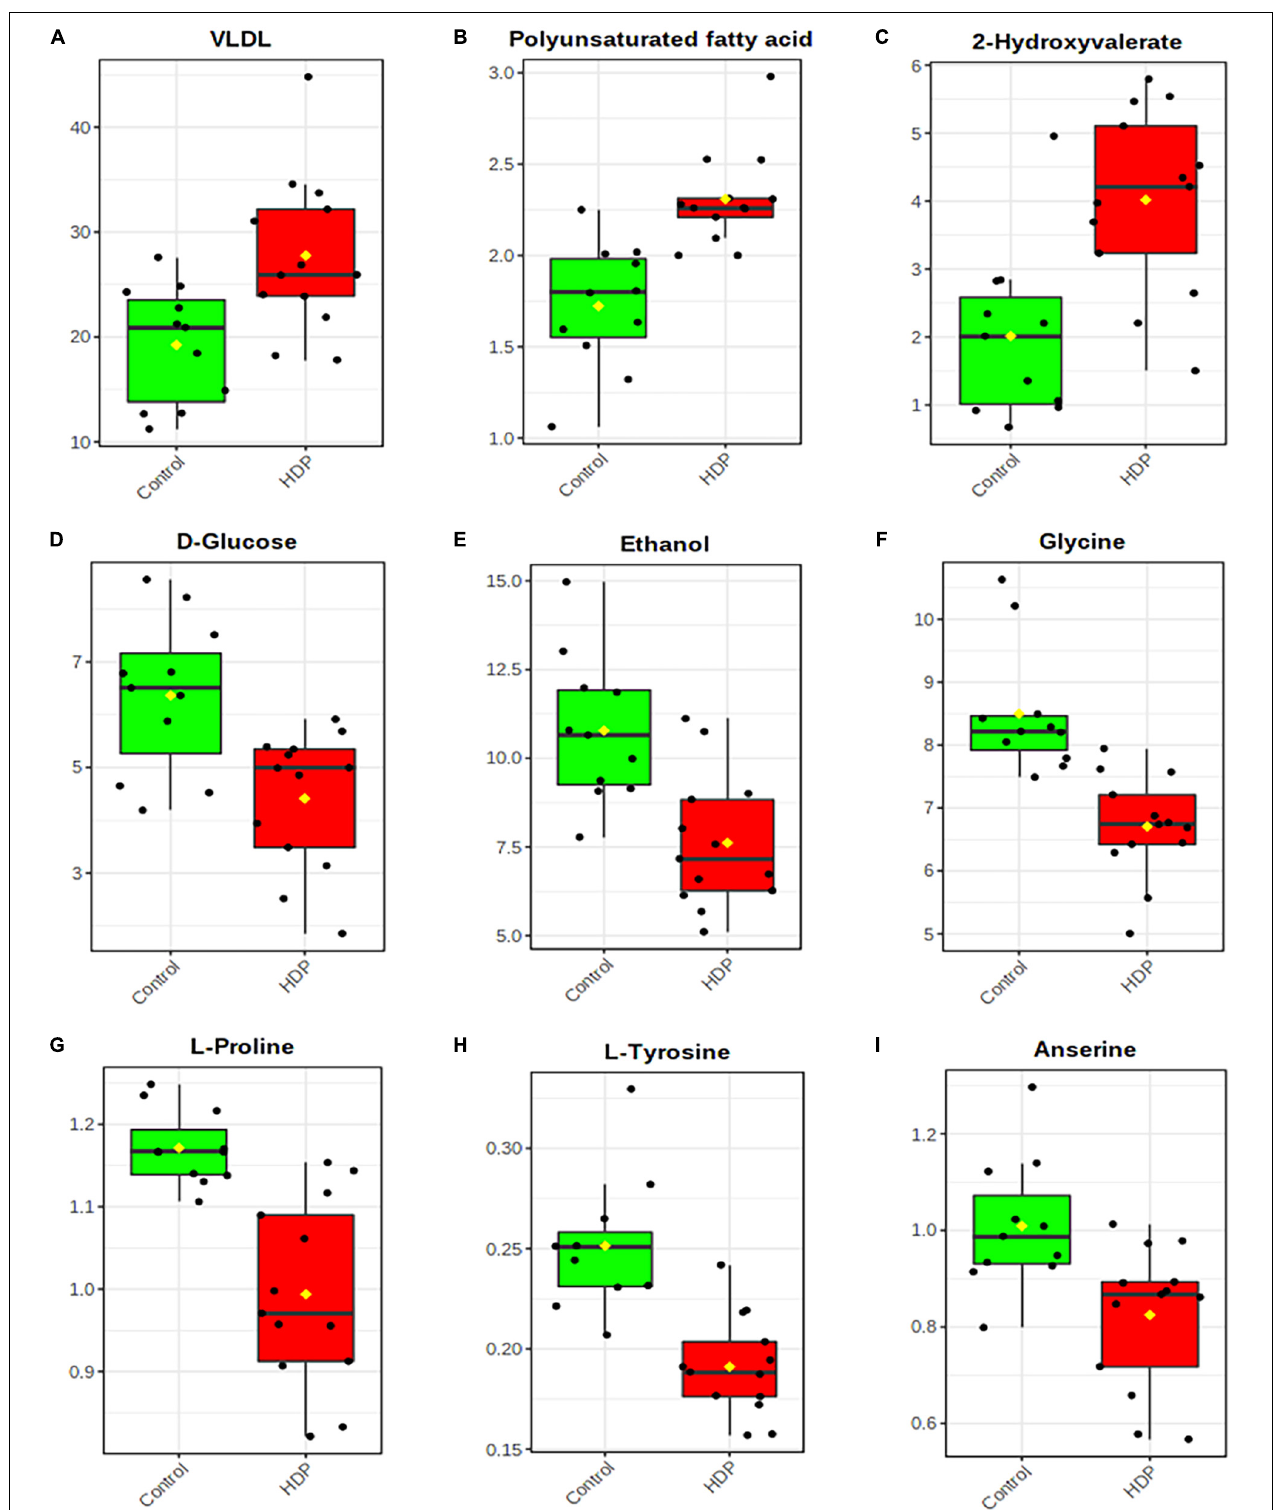
FIGURE 5 | Exosome-enriched plasma metabolite analysis. Box-and-whisker plots of relative concentrations for some significantly altered metabolites ( p < 0.01): (A) VLDL; (B) Polyunsaturated fatty acids; (C) 2-Hydroxyvalerate; (D) D -Glucose; (E) Ethanol; (F) Glycine; (G) L -Proline; (H) L -Tyrosine; (I) Anserine. Y-axes are represented as relative units and medians are indicated by horizontal lines within each